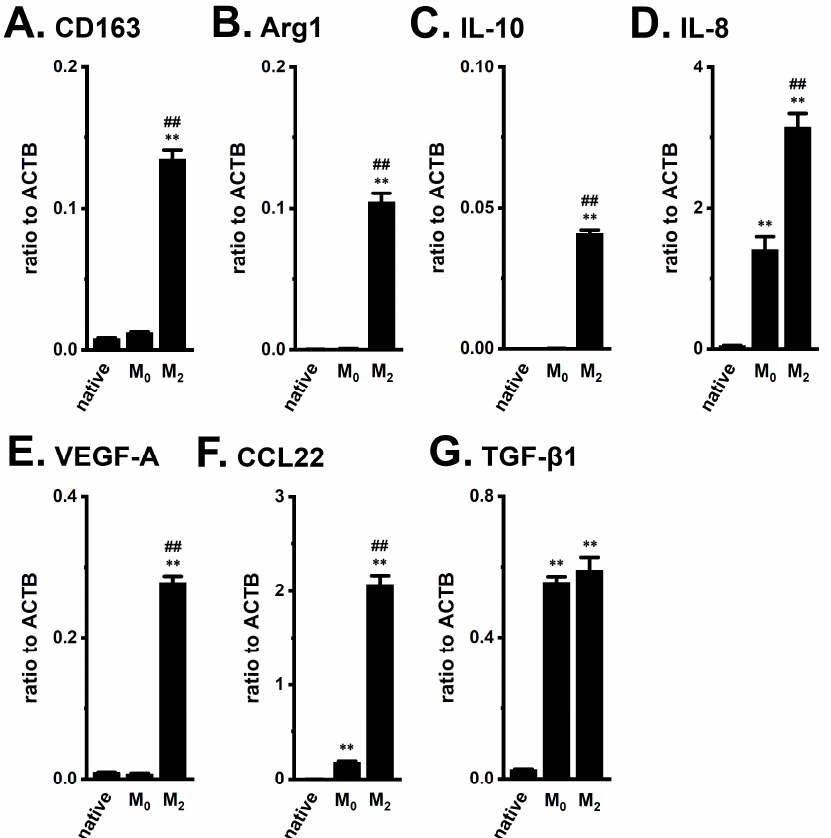
Figure 1. Gene expression of M 2 markers, cytokines, chemokines, and growth factors in THP-1-de- rived M 2 -like macrophages. A–G: Real-time PCR examination of CD163 ( A ), Arg1 ( B ), IL-10 ( C ), IL- 8 ( D ), VEGF-A ( E ), CCL22 ( F ), and TGF-β1 ( G ) expression in native THP-1 (‘native’), THP-1-derived M 0 -like macrophages (‘M 0 ’), and THP-1-derived M 2 -like macrophages (‘M 2 ’). Expression levels are shown as a ratio to ACTB (n = 4 for each). **: p < 0.01 vs. ‘native’, ## : p < 0.01 vs. ‘M 0 ’.